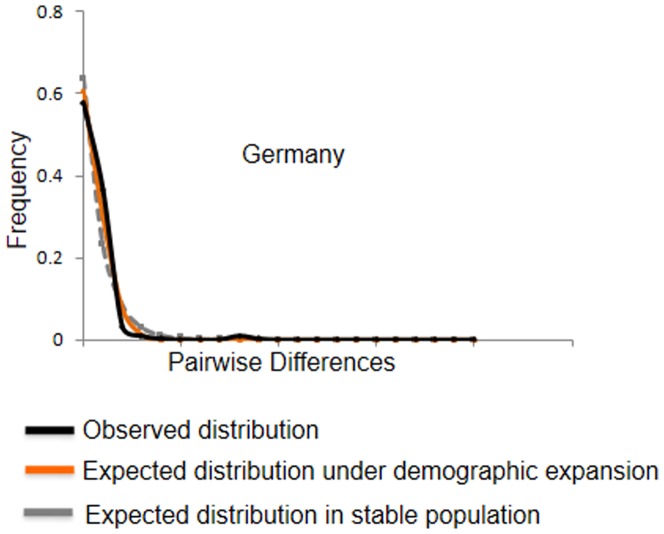
Mismatch distributions of D-loop haplotypes found in Germany.Expected distributions were modeled for stable populations and populations undergoing demographic expansion by using the parameters τ = 0.5, θ0 = 0 and θ1 = 99999.